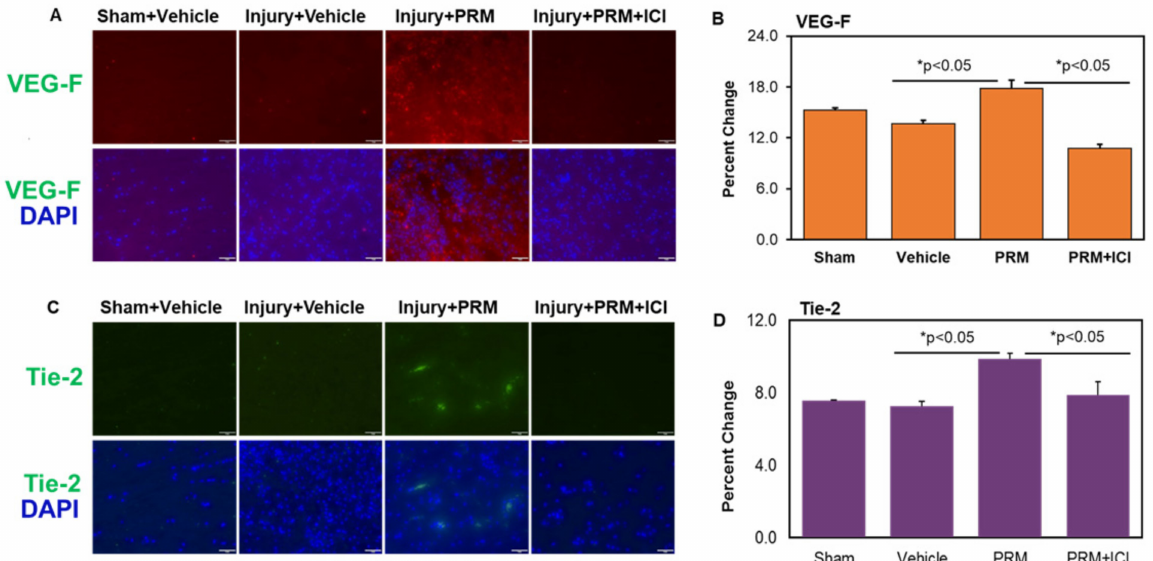
Figure 7. PRM improved angiogenesis at day 7 following SCI. PRM treatment increased the expres- sion levels of angiogenic proteins VEG-F ( A , B ), and Tie-2 ( C , D ) in SCI as determined by immunohis- tochemistry and quantitative image analysis. Both angiogenic markers were slightly decreased in vehicle treated rats which were significantly elevated after PRM treatment. The observed increase in angiogenic protein expression by PRM injured rats was reversed by ER antagonist ICI ( B , D ). Representative immunofluorescent staining images using antibodies against VEG-F and Tie-2 are also shown ( A , C ) along with corresponding quantitation ( B , D ) (magnification, 200 × , n =